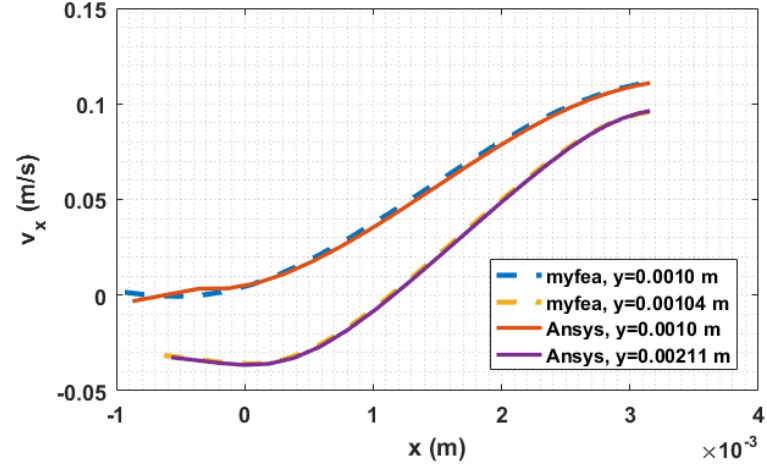
Figure A2. Velocity profiles in the extrusion-deposition transition zone.